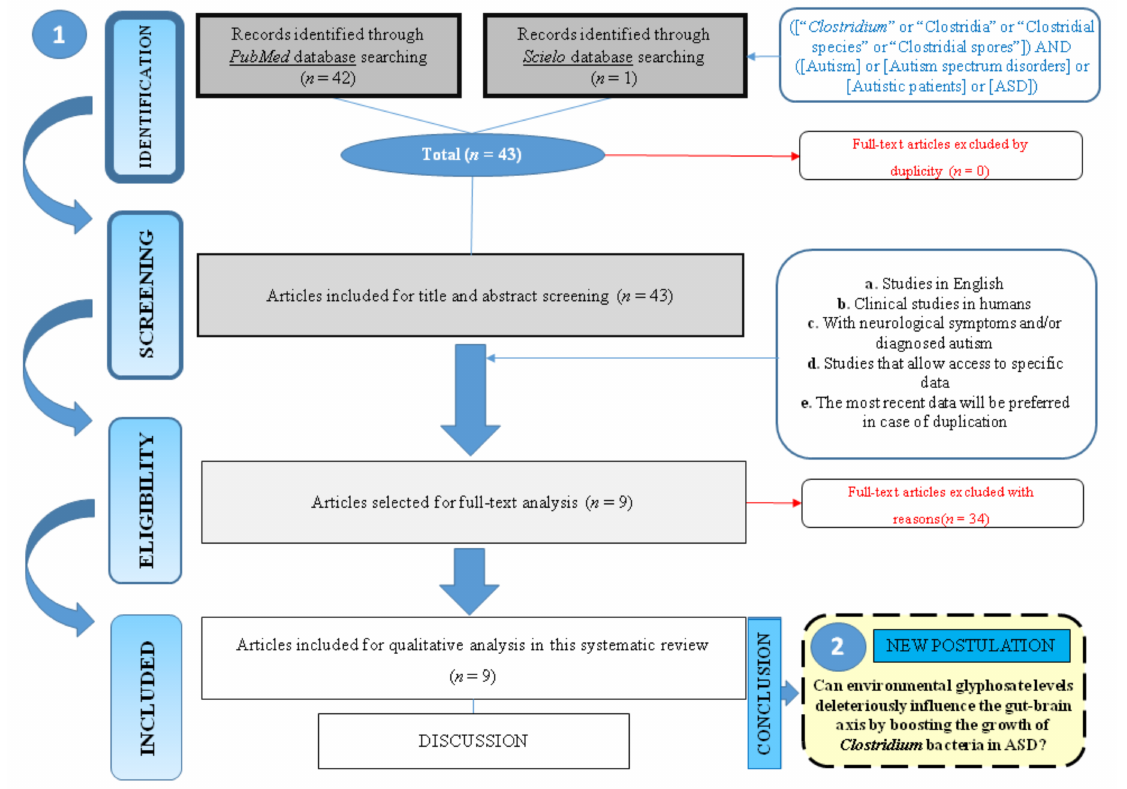
Figure 1. Graphical abstract representing (1) the article selection flow chart of the systematic review and (2) final